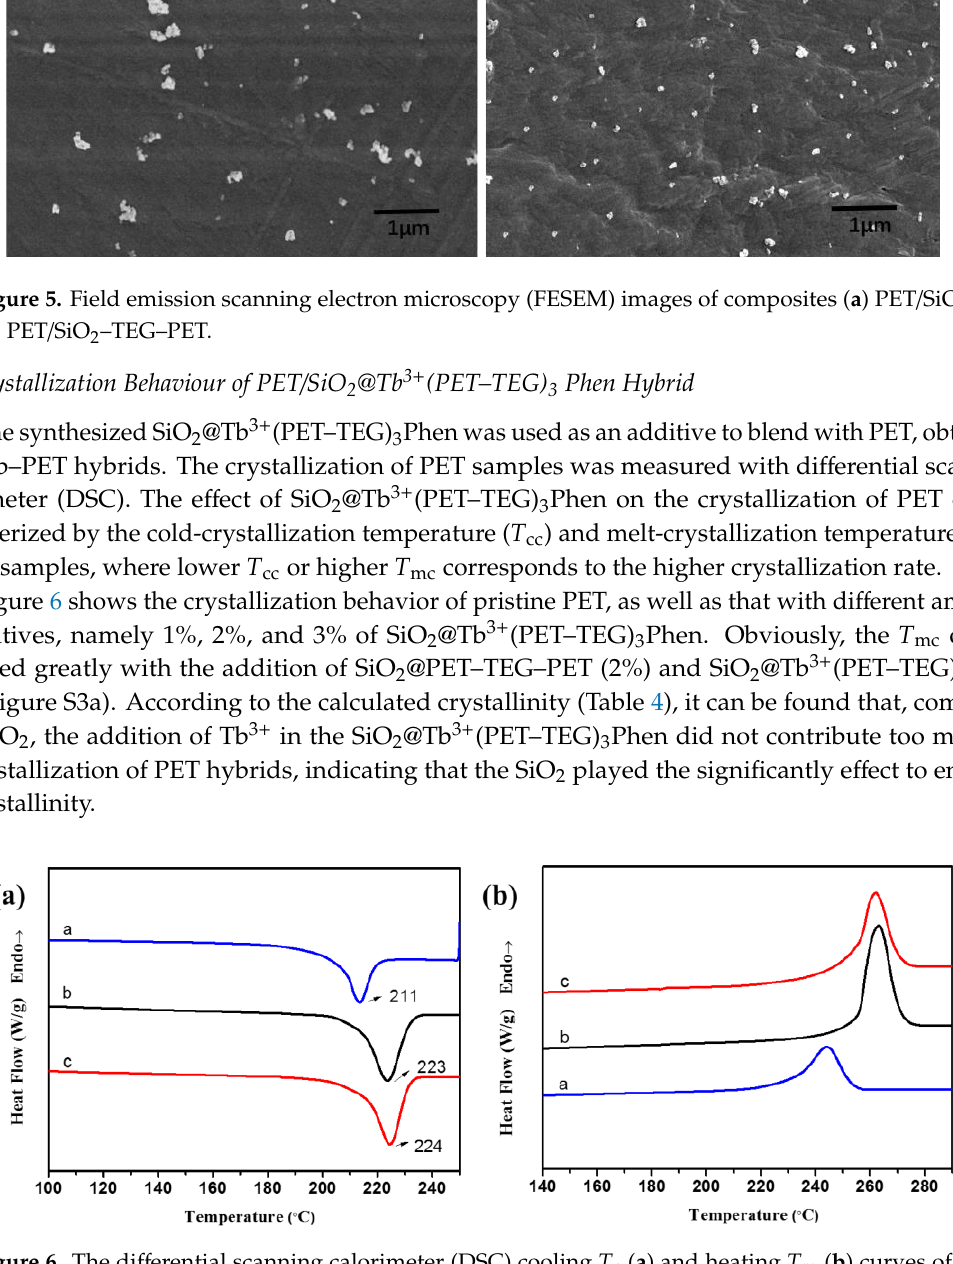
Figure 6. The differential scanning calorimeter (DSC) cooling T c ( a ) and heating T m ( b ) curves of a: PET, b: 2%SiO 2 –PET–TEG, and c: 2%SiO 2 @Tb 3+ (PET–TEG) 3 phen. Table 4. Thermodynamic performance of composites.